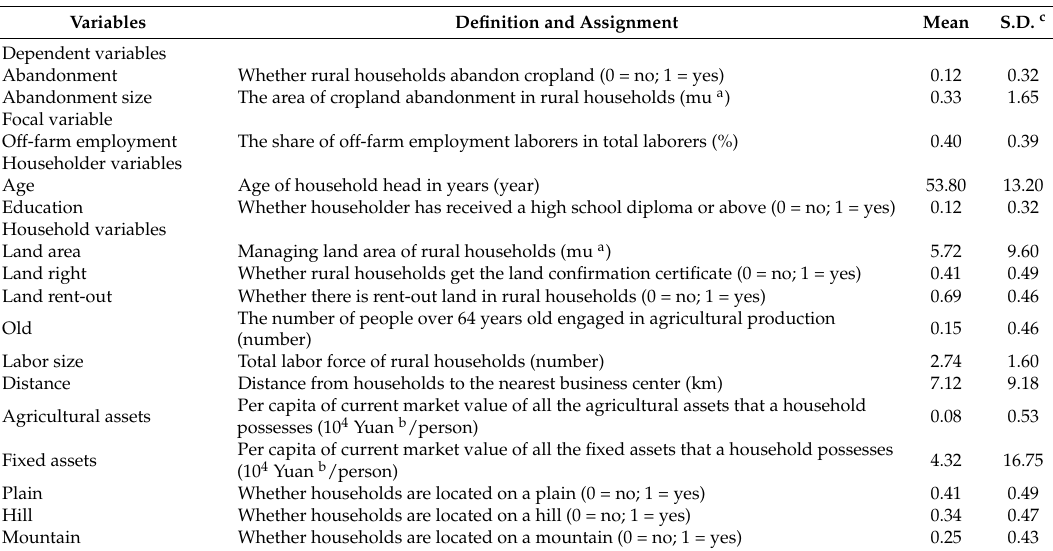
Table 1. The definition and data description of the variables in the